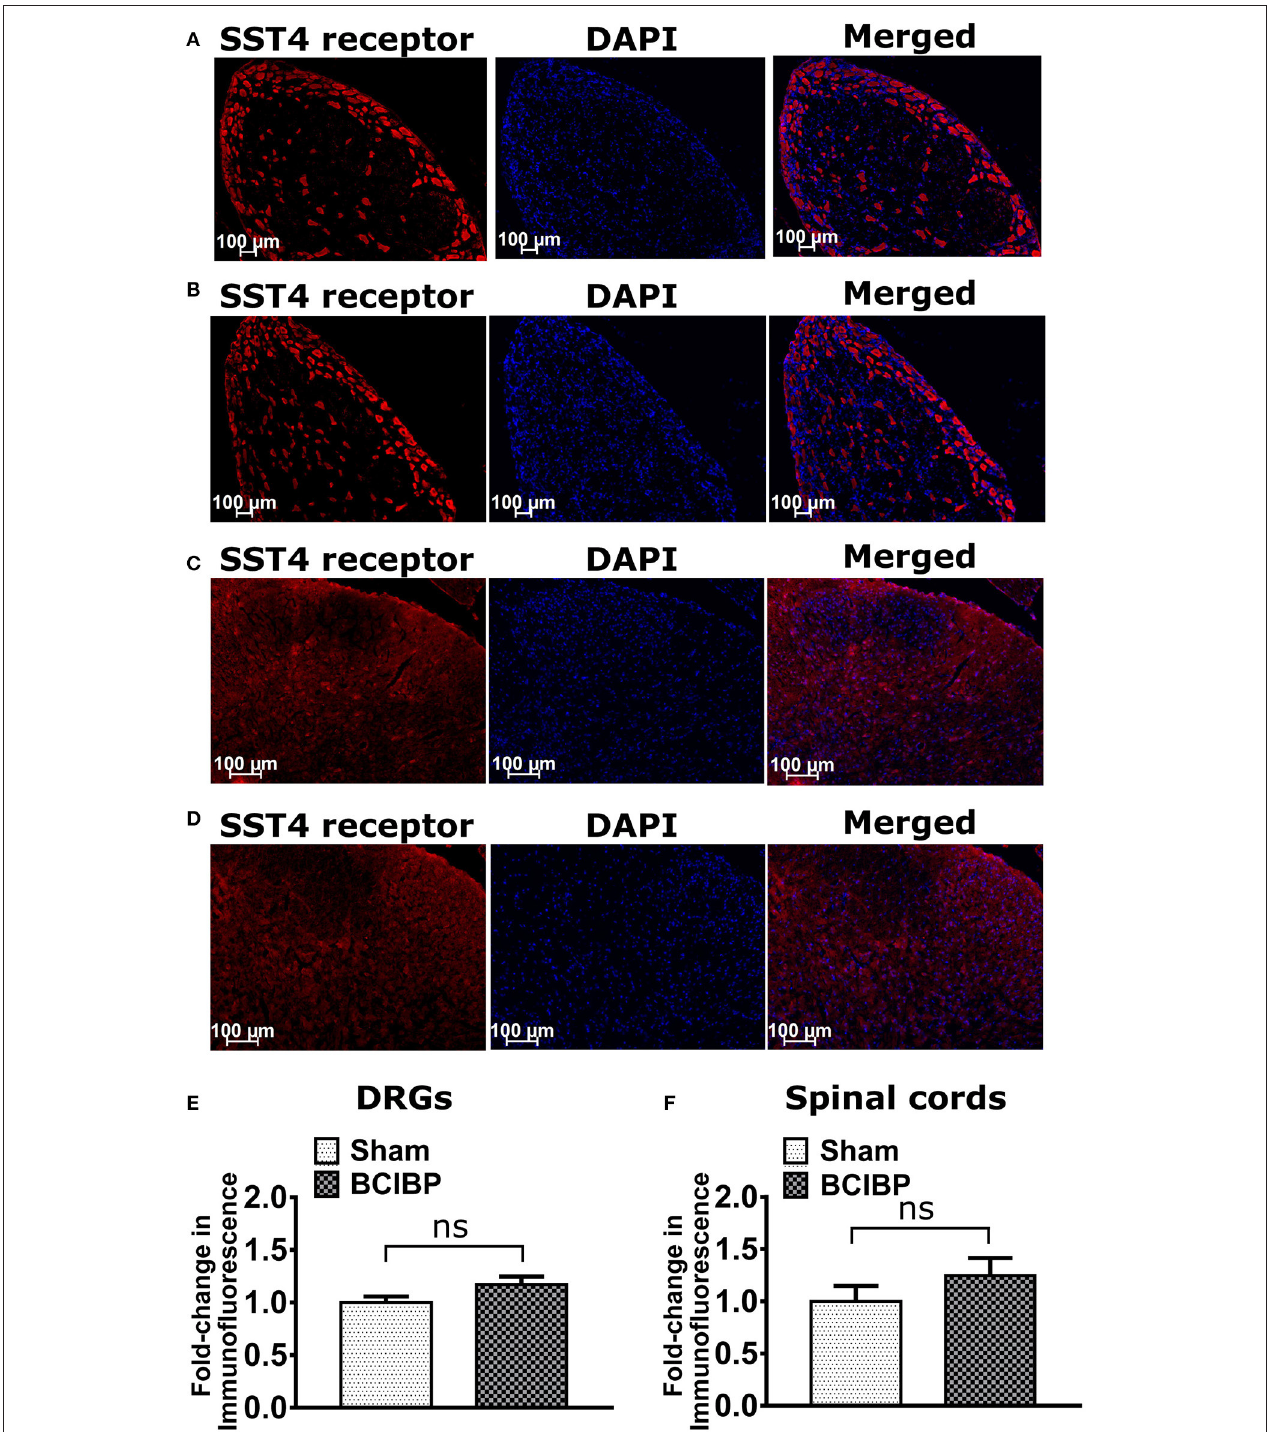
FIGURE 5 | Expression levels of SST4 receptor in sections of ipsilateral lumbar L4-L6 dorsal root ganglia (DRGs) and lumbar spinal dorsal horns of BCIBP-rats and the corresponding sections from sham rats ( n = 3–4/group). Panels in the figure show representative sections of (A) DRG of a sham rat, (B) DRG of a BCIBP-rat, (C) spinal dorsal horn of a sham rat and (D) spinal dorsal horn of a BCIBP-rat. Panel (E) shows fold-change in immunofluorescence of DRG sections of the BCIBP group relative to the sham group and (F) shows fold-change in immunofluorescence of lumbar spinal cord sections of the BCIBP group relative to the sham group. ns, statistically not significant ( p > 0.05, Mann-Whitney